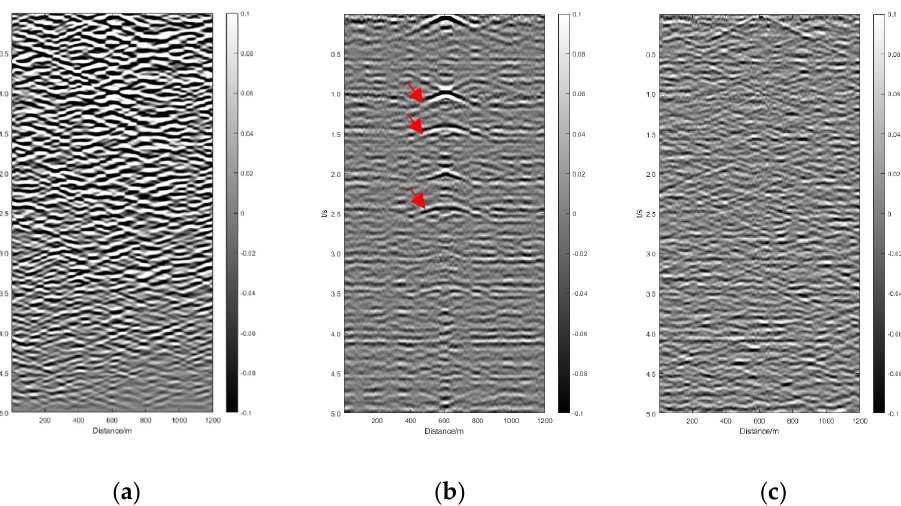
Figure 7. The result before and after data set processing by the neural network, and the difference between the result and the reconstruction result of passive seismic records with long periods. ( a ) The reconstructed result of passive seismic records with short periods; ( b ) the result of the test data processed by the neural network; ( c ) difference between processing results and the reconstruction result of passive seismic records with long periods.